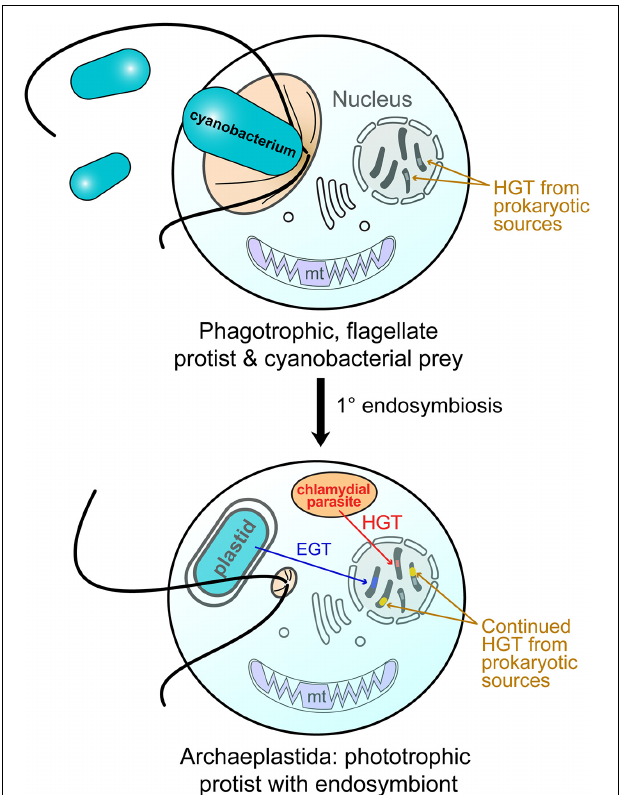
FIGURE 1 | Endosymbiotic origin of the Archaeplastida plastid through cyanobacterial primary endosymbiosis. (top) A heterotrophic protist engulfed free-living cyanobacteria for food (phagocytosis). Over time, this situation changed, with the cyanobacterium becoming an endosymbiont (bottom). A chlamydial cell is believed to have also been resident in the host at the time of endosymbiosis and provided functions critical to plastid integration (Ball et al., 2013). Both of these prokaryotes gave rise to nuclear genes in the Archaeplastida host through endosymbiotic gene transfer (EGT; cyanobacterium) and horizontal gene transfer (HGT; chlamydial cell and other bacteria). After their split, the red and green algae gave rise to the plastid in other algae through independent secondary endosymbiosis (Bhattacharya et al., 2004; Curtis et al., 2012). The intracellular transfer of genes via EGT and HGT is indicated (arrows). Genetic material of foreign origin in the nucleus is shown as stripes of different colors with the color indicating the source of the